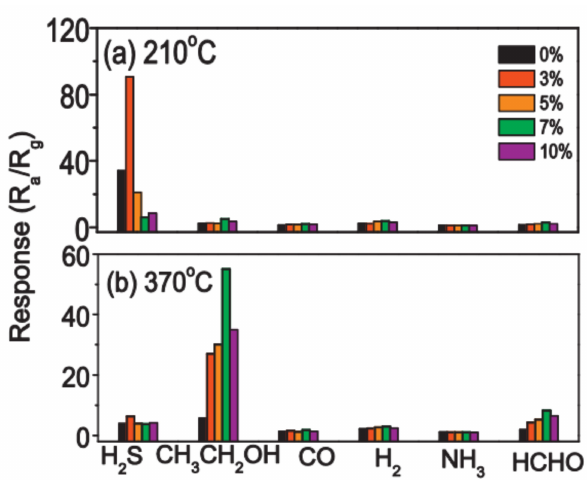
Figure 17. The selective test of SnO 2 :Ce nanofiber-based sensors toward ( a ) 20 ppm H 2 S and 200 ppm ethanol, CO, H 2 , NH 3 and formaldehyde at T oper = 210 ◦ C, and ( b ) 200 ppm H 2 S, ethanol, CO, H 2 , NH 3 and formaldehyde at T oper = 370 ◦ C. Reprinted with permission from [240]. Copyright 2013